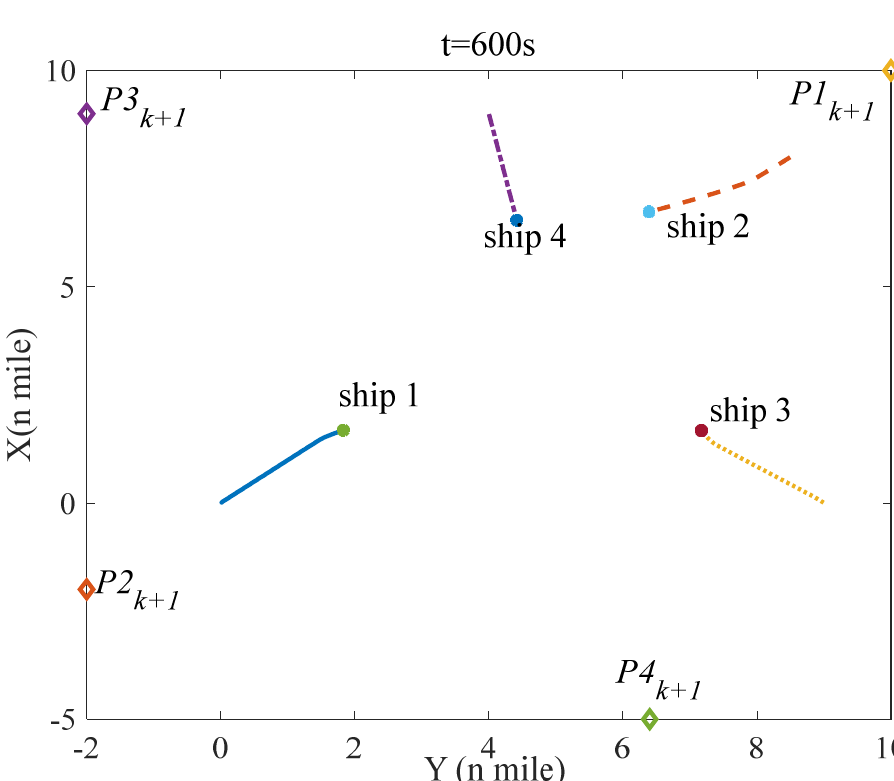
Figure 13. The situation of four ships at t = 600 s in scenario 2.